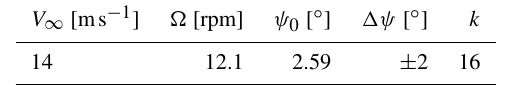
Table 4. Inputs defining the pitch step.